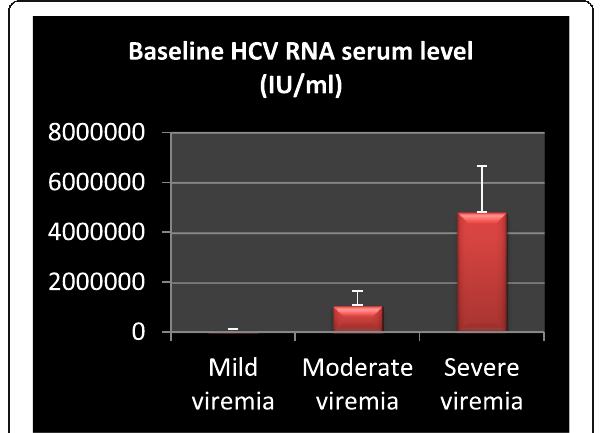
Fig. 1 Baseline HCV RNA levels